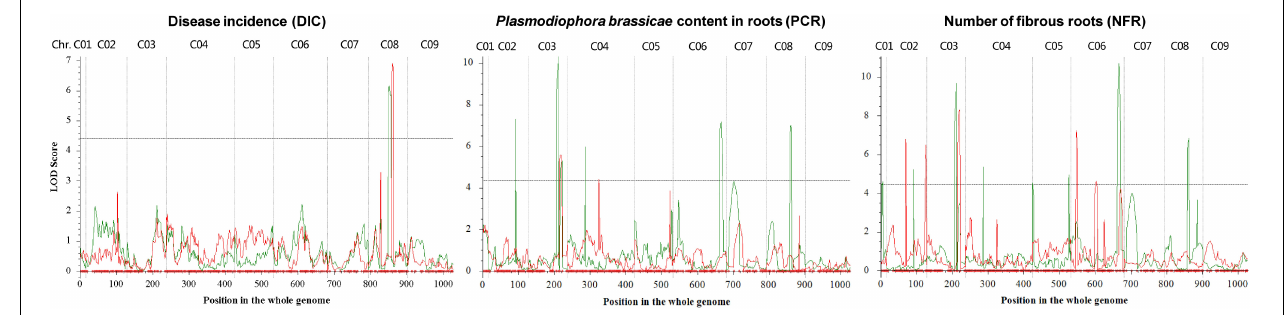
FIGURE 3 | Quantitative trait loci scanning for clubroot resistance associated traits in B. oleracea in the first (red) and the second replication (green).